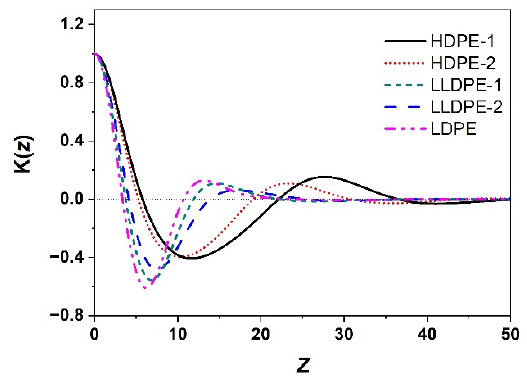
Figure 4. One-dimension correlation functions of the neat PEs used in this work.